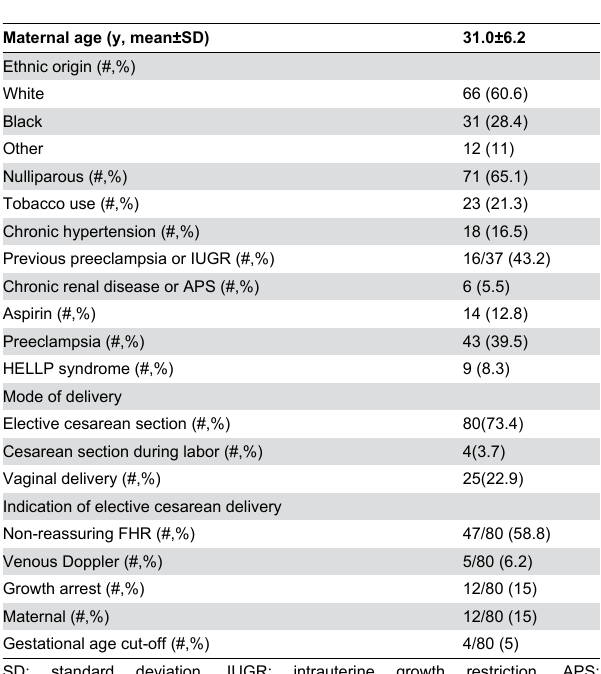
Table 1. Demographics, pregnancy, and management